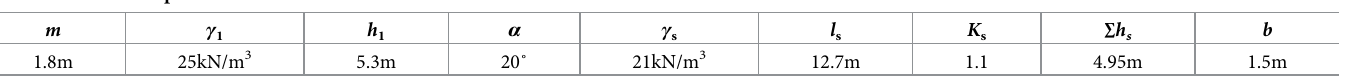
Table 6. Calculation parameters of MSSC in No.8 coal seam.